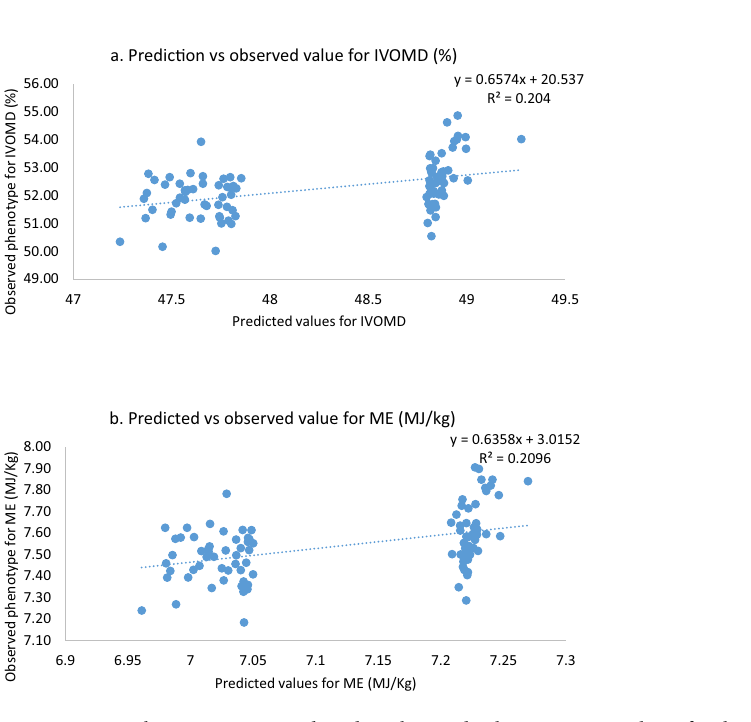
Figure 6. Graph representing predicted vs observed values among DH lines for the two stover quality traits ( a ) IVOMD and ( b )